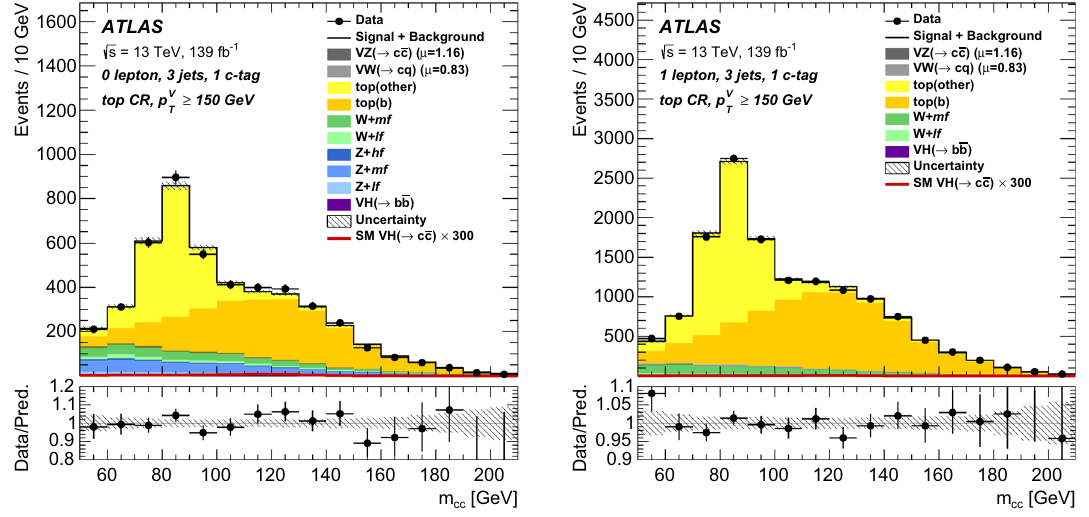
Fig. 14 Post-fitdistributions ofthe0-and1-lepton topcontrol regions. The total signal-plus-background prediction is shown by the solid black line and includes the H → c ¯ c signal scaled to the best-fit value of = − 9. The H → c ¯ c signal is also shown as an unfilled his- μ VH ( c ¯ c )